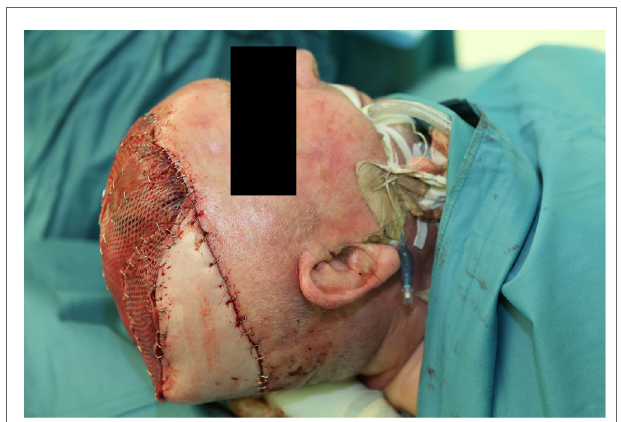
FiGURe 8 | intraopearative view after fitting of the flaps . Note the more resilient skin cover of the parascapular flap over the occiput on which the head rests.